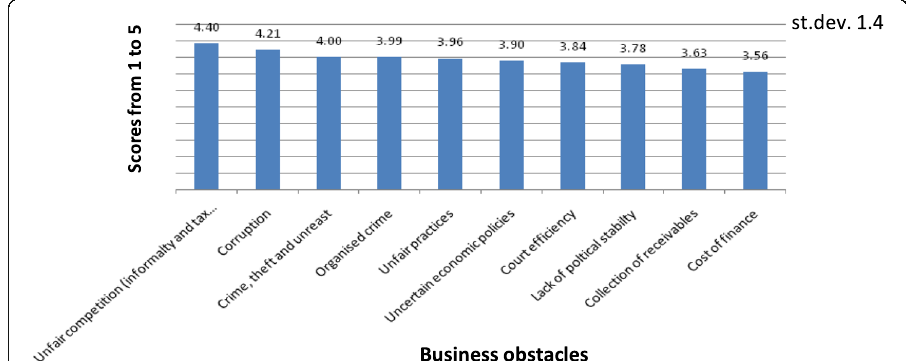
Fig. 6 Top 10 obstacles ranked by firm managers. Source: Riinvest Survey